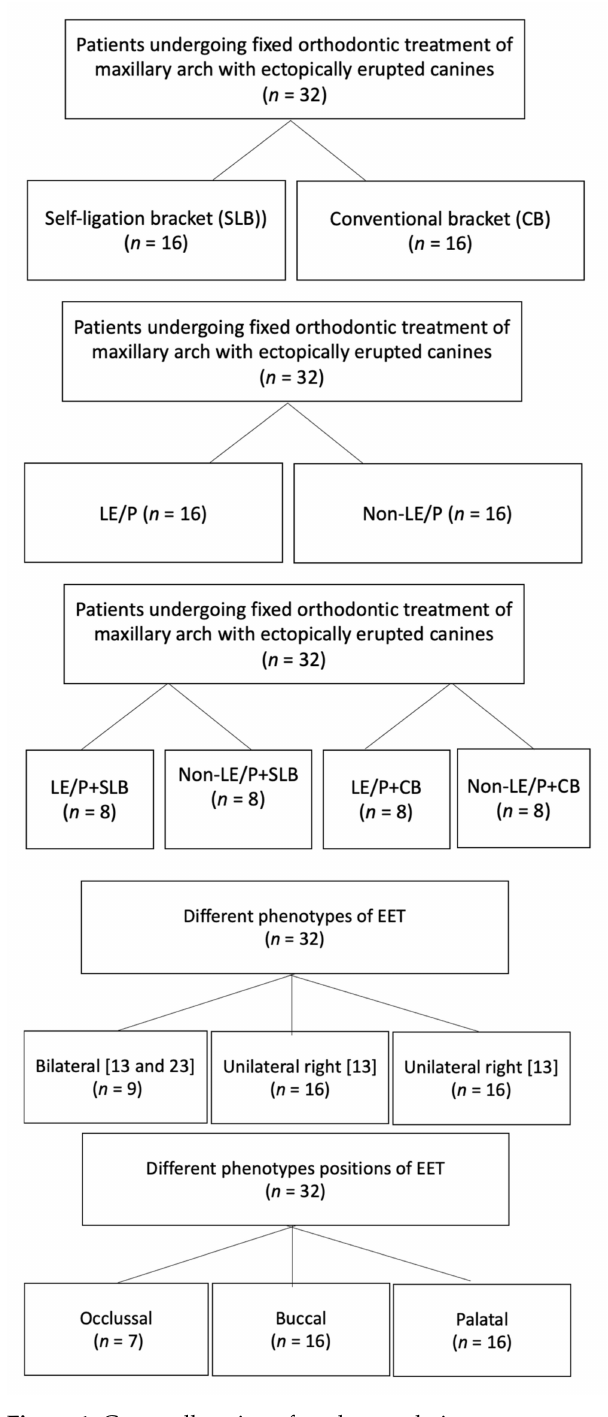
Figure 1. Group allocation of study